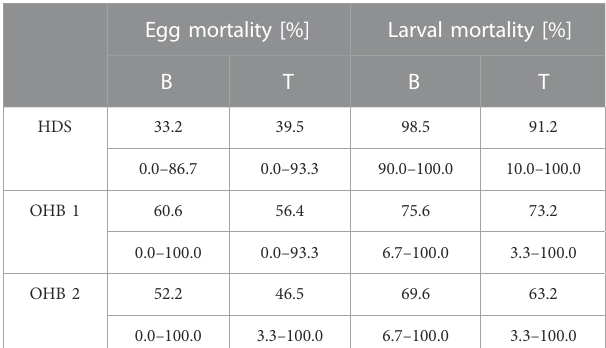
TABLE 3 Egg mortality and larval mortality detected in the top and bottom compartments of the HEST in the assessed Ottheinrichbach (OHB) and the groundwater-in fl uenced hinterland draining system Längenmühlbach (HDS). Upper layer indicates mean mortality rates for eggs and larvae respectively, whilst the lower layer indicates minimum and maximum